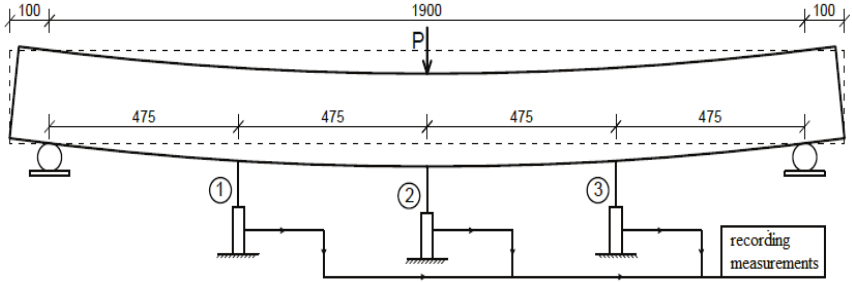
Fig. 6. Scheme of the measurement